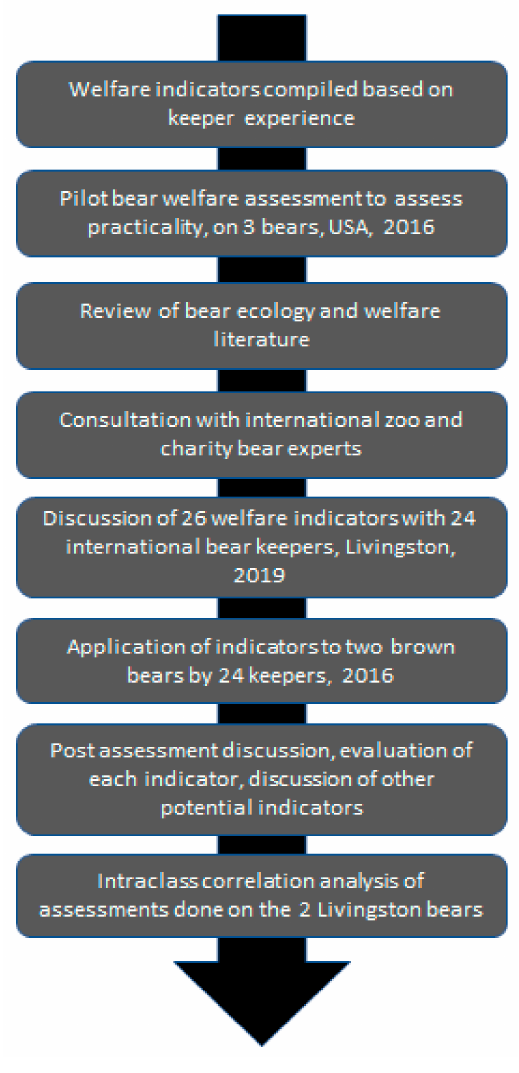
Figure 1. The process of development and refinement of welfare indicators taken from the literature and industry